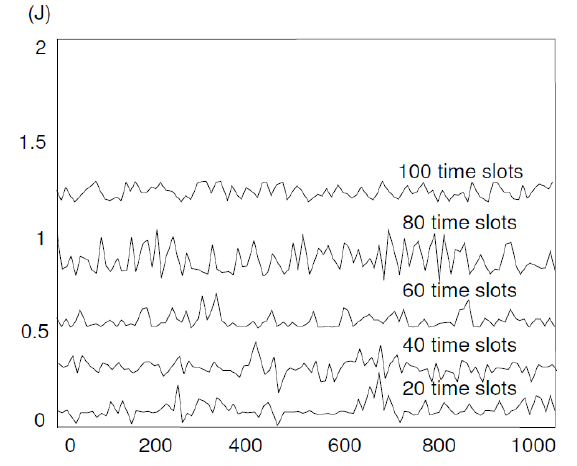
Figure 10. Energy consumption status of 1,000 sensors randomly distributed over a 100*100 square meters network area under single-event scenario, associated with Figure 11.